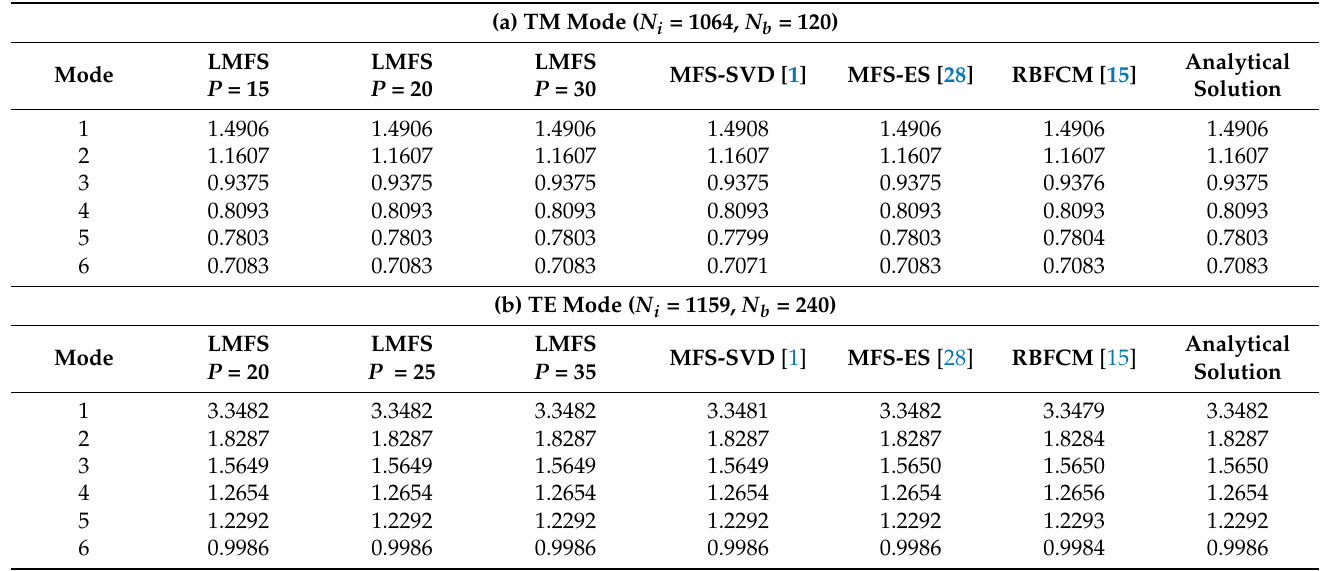
Table 1. Comparison of the first six cutoff wavelengths for the elliptic waveguide in case